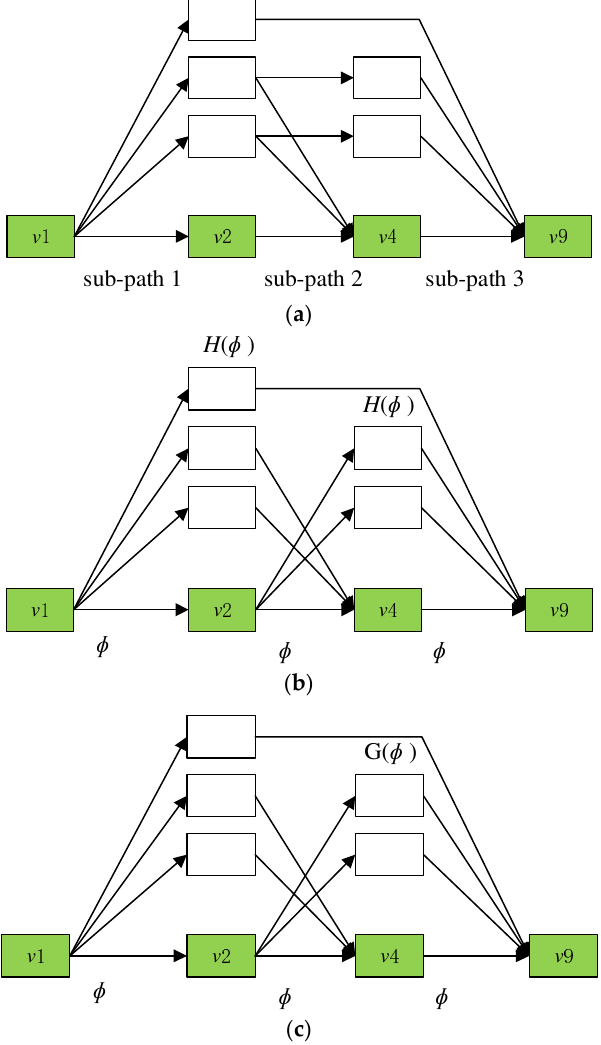
Figure 3. The CPCM of a DAG. ( a ) the CP is divided into a set of consecutive sub-paths based on the potential delay it can incur. ( b ) execute in parallel with the sub-path. ( c ) delay the start of the next sub-path, based on precedence constraints.